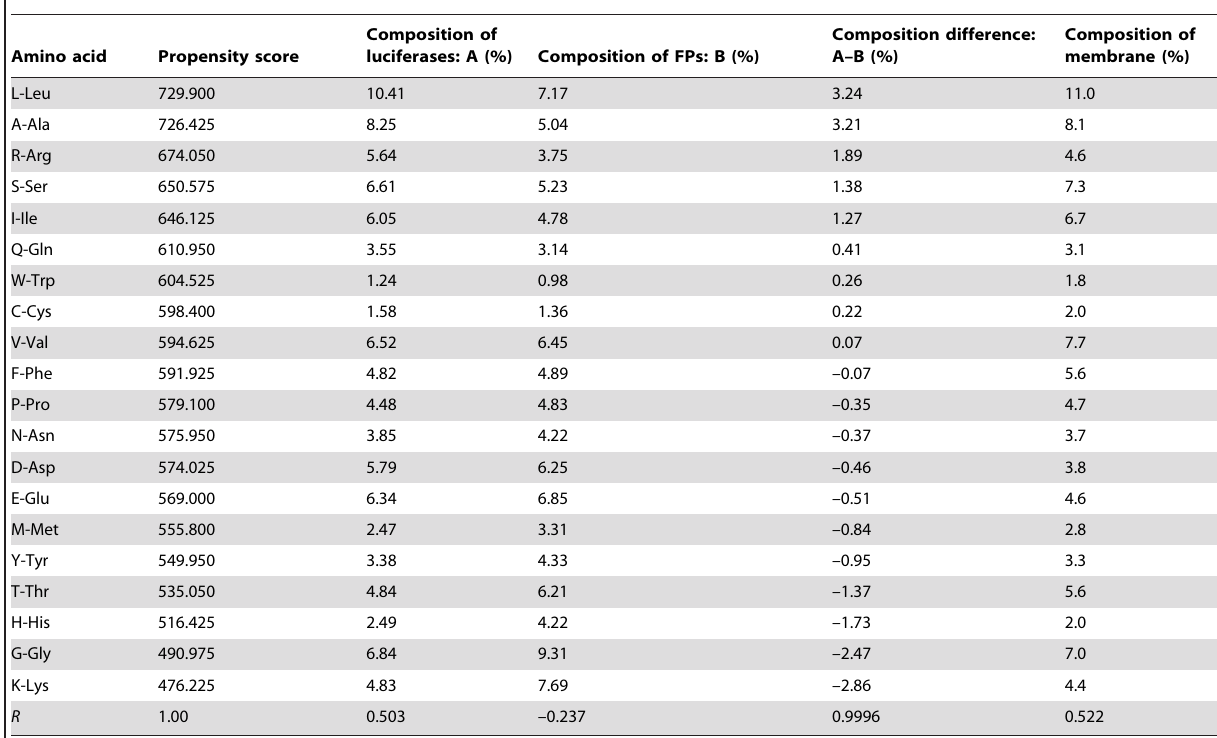
Table 6. The propensity scores of amino acids for distinguishing luciferases from FPs.